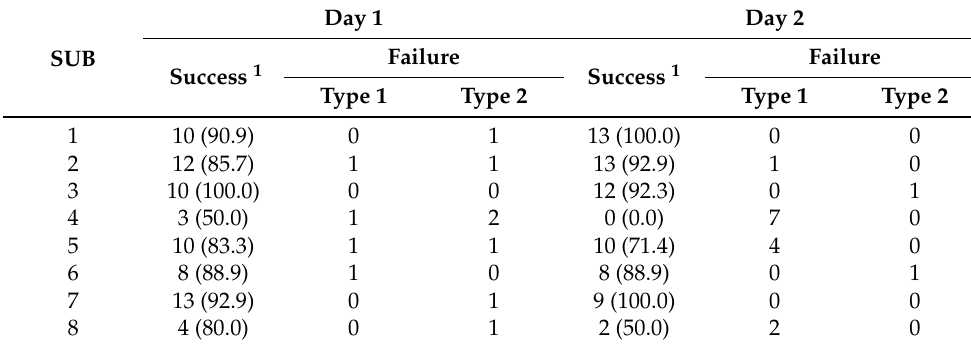
Figure 5. Average trial completion time ( a ) and average path efficiency ( b ) over two days. The whiskers correspond to the standard deviation. Subject 4 was excluded as the subject was unable to complete any trial on the second day. Table 2. Number of successful and failed trials for two consecutive days.